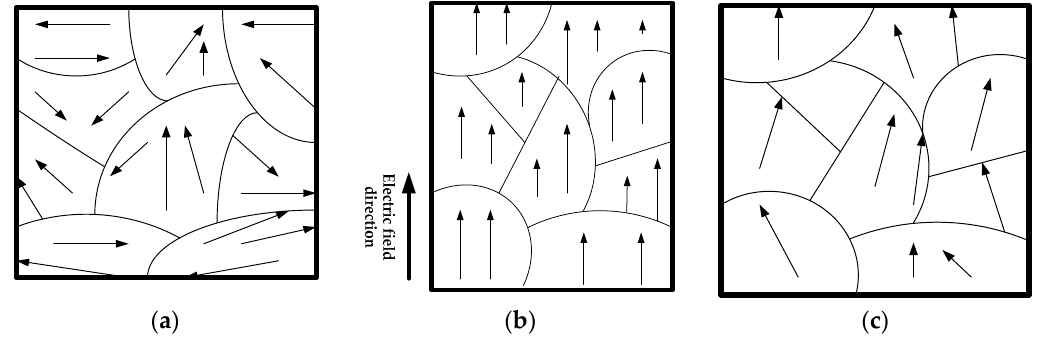
Figure 4. Schematic diagram of the spontaneous polarization alignment: ( a ) before; ( b ) during; ( c ) after presence of an electric field.